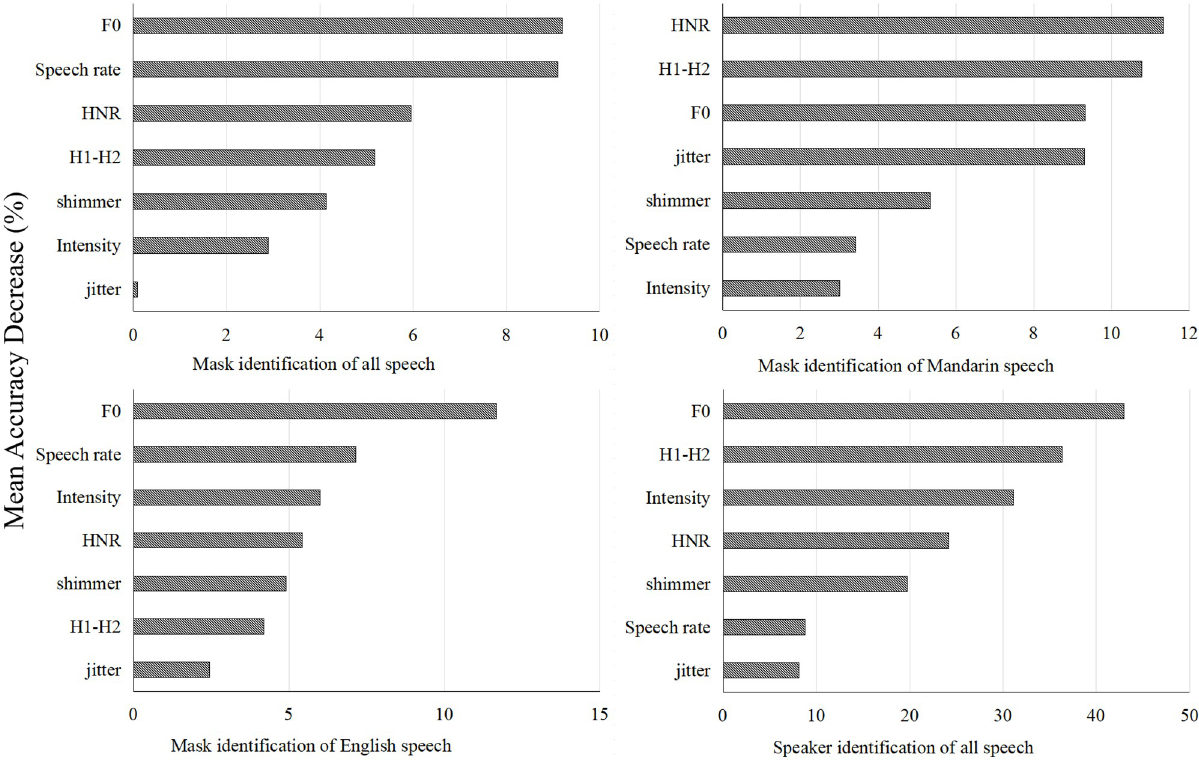
Fig 7. The significance of the seven acoustic parameters in the random forest models for mask speech identification (data: All speech, Mandarin speech, and English speech) and individual speaker identification (data: All speech mixed by mask and no mask speech).